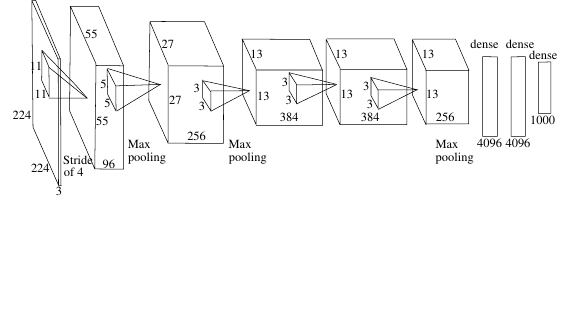
Figure 5. Architecture of the AlexNet, where the most conventional CNN architectures are derived